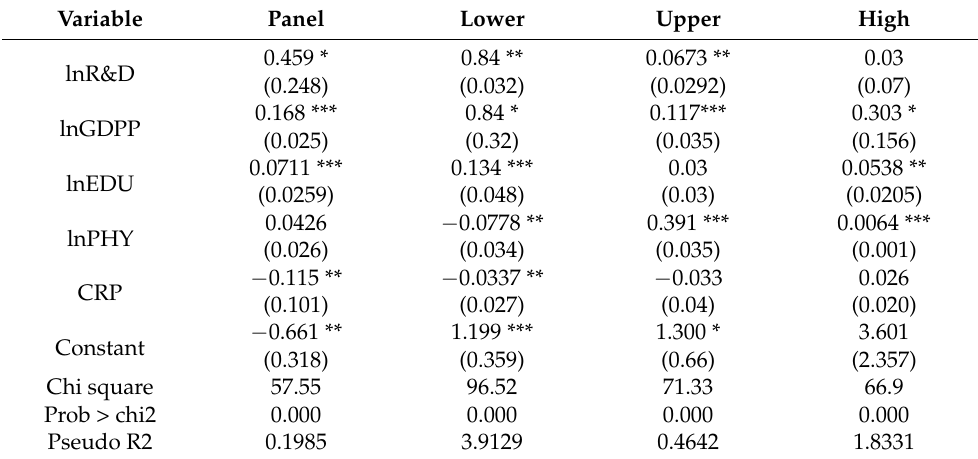
Table 5. Model 1: Tobit